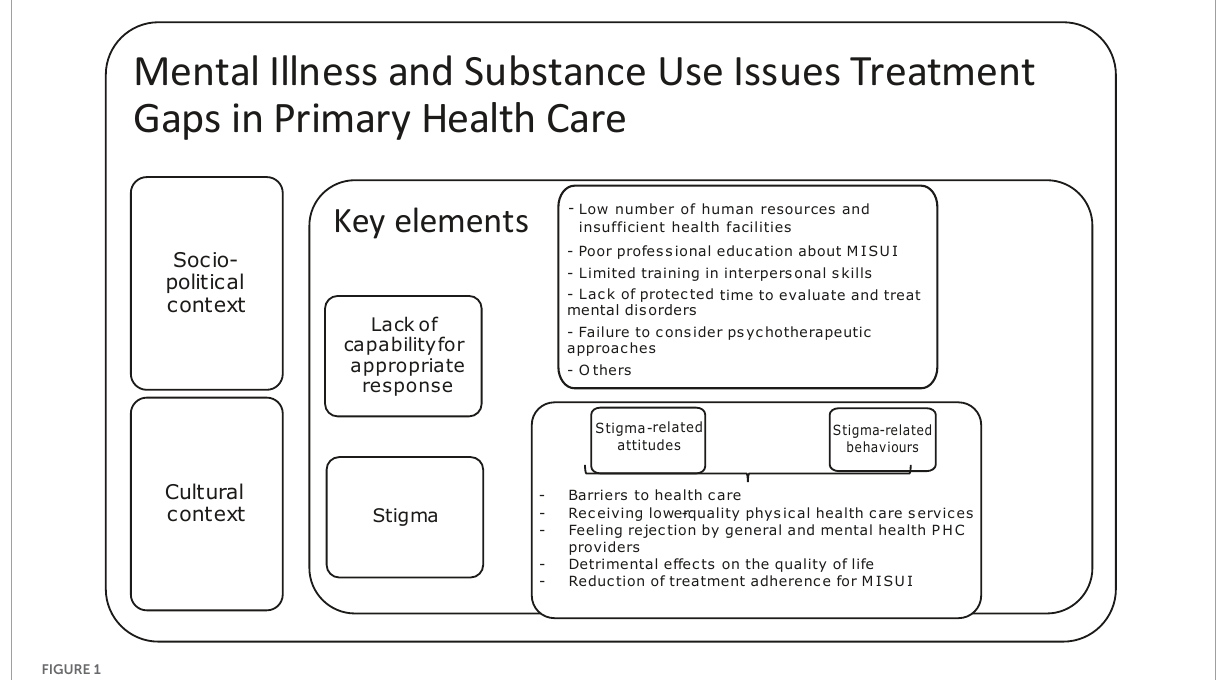
FIGURE1 Gaps in MISUI treatment in primary health